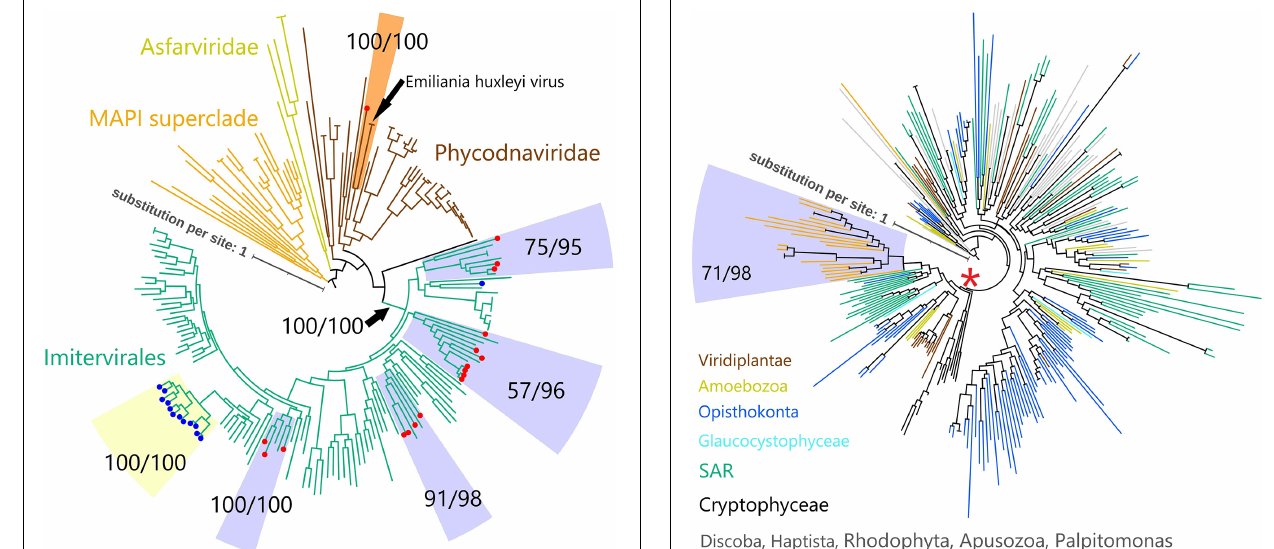
FIGURE 2 | Phylogenetic tree of NCLDVs based on DNA polymerase B. The tree was built from an alignment (993 sites) of 205 PolB sequences of NCLDVs (18 MAGs encoding myosin gene, 13 MAGs encoding actin gene, and 174 other broad and unbiased taxa from the reference database). Branches labeled with red and blue circles represent NCLDV MAGs with virmyosin and viractin genes, respectively. Branches are color-coded based on family- or order-level taxonomy. The MAPI superclade (shown in orange) comprises Marseilleviridae , Ascoviridae , Pitho-like viruses, and Iridoviridae . Paired-numerical values represent the non-parametric bootstrap (left) and TBE (right) values for the branch support. Phycodnaviridae MAG with virmyosin is phylogenetically close to Emiliania huxleyi virus with maximum bootstrap and TBE supports. We used MAPI superclade as an outgroup to root the tree. The LG + F + R10 substitution model was selected by IQ-TREE for the best model for tree reconstruction.